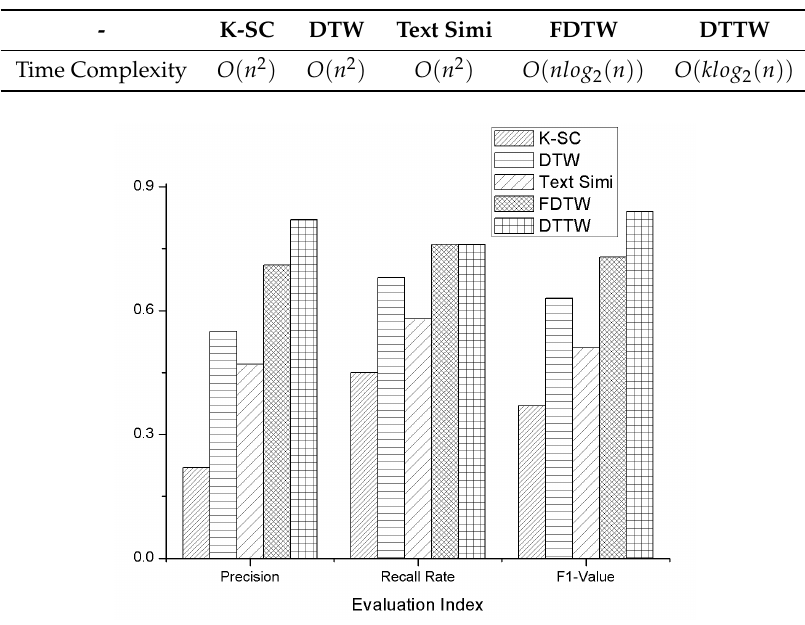
Table 1. Comparison of time complexity.